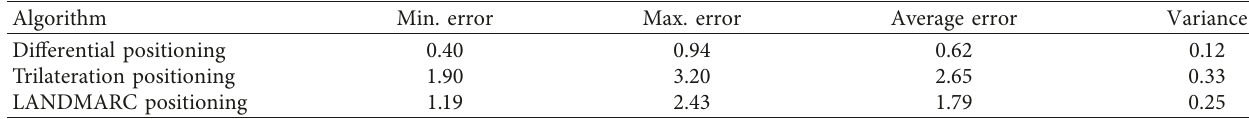
Table 4: Comparative experimental results: RMSE summary statistics (Bluetooth